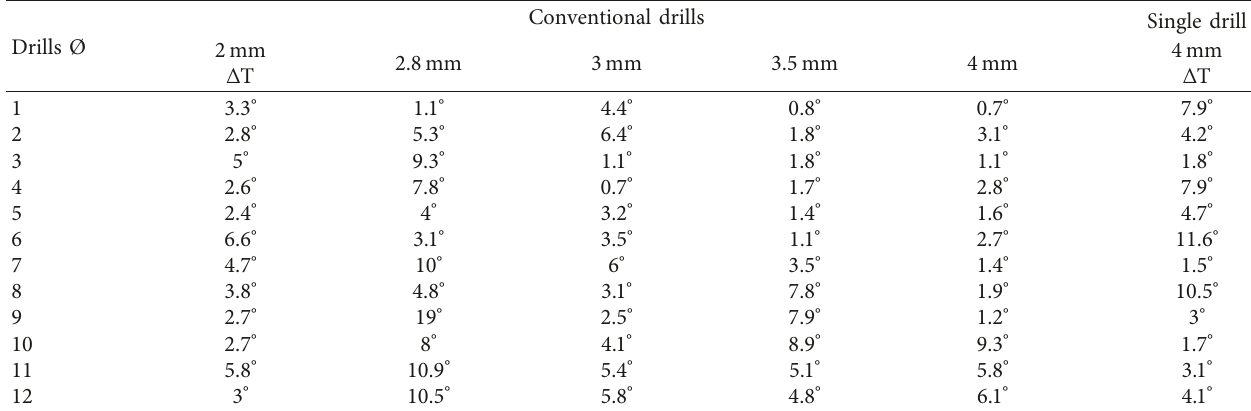
max –T0) for the groups A and B.